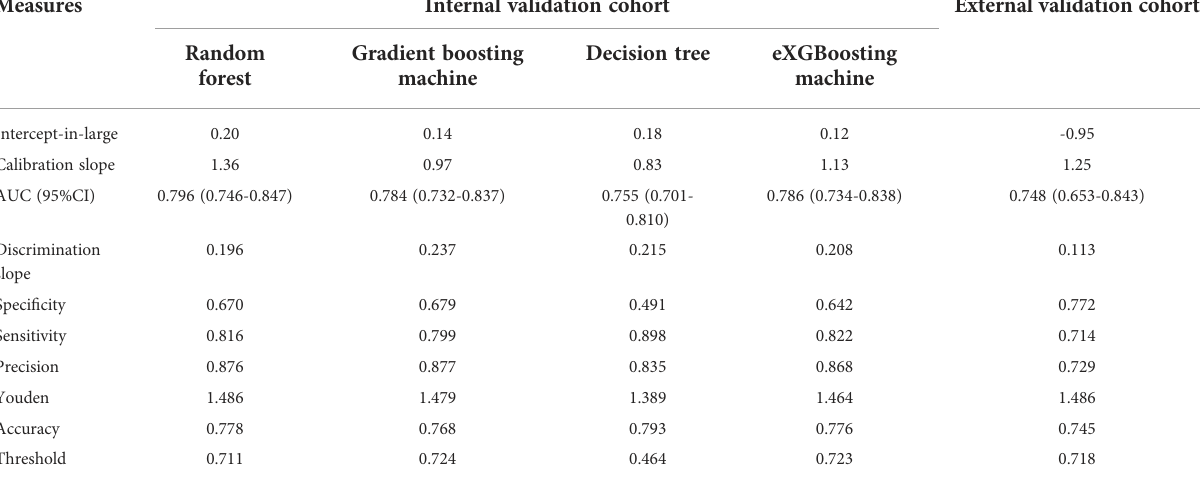
TABLE 4 Prediction performance of machine learning approaches for predicting three-month mortality among bone metastatic patients from CUP. Measures Internal validation cohort External validation cohort Random Gradient forest